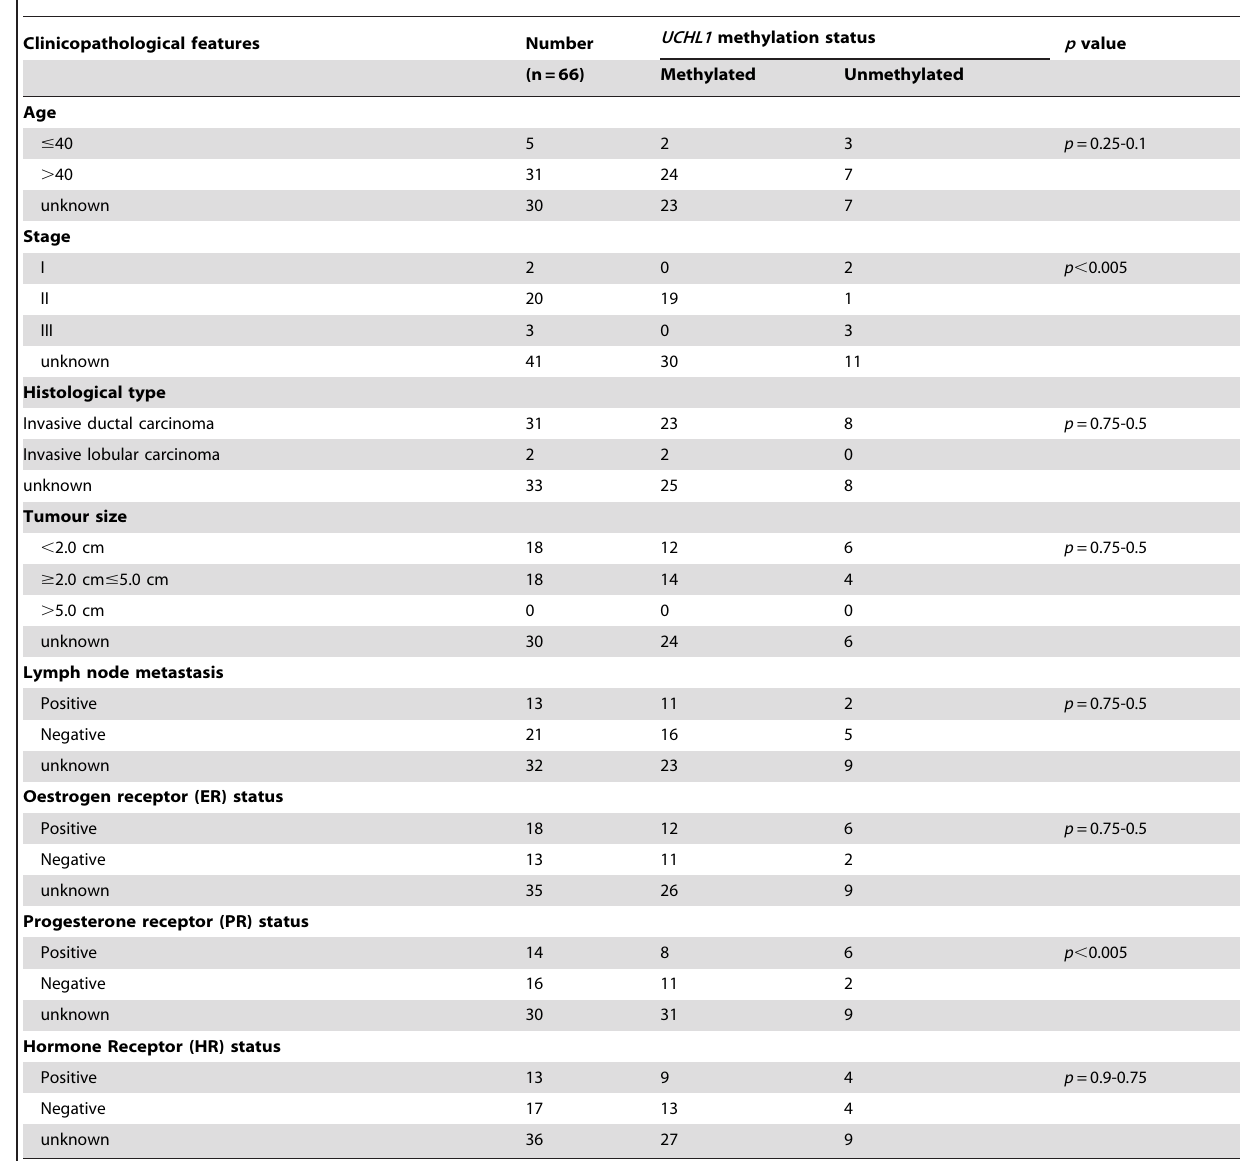
Table 2. Clinicopathological features and UCHL1 methylation of breast tumors.